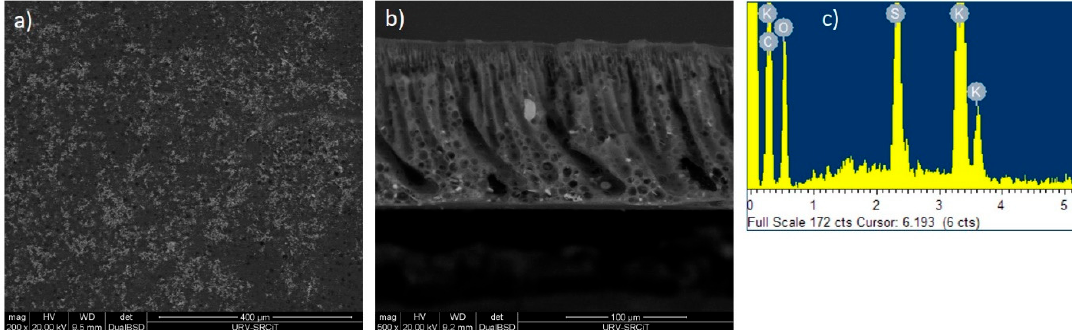
Figure 8. ESEM micrographs with BSED of L2 membrane after four experiments in a flat sheet membrane contactor: ( a ) bottom surface; ( b ) cross-section; ( c ) X-ray analysis (EDX) analysis of the white spots seen in the micrographs.